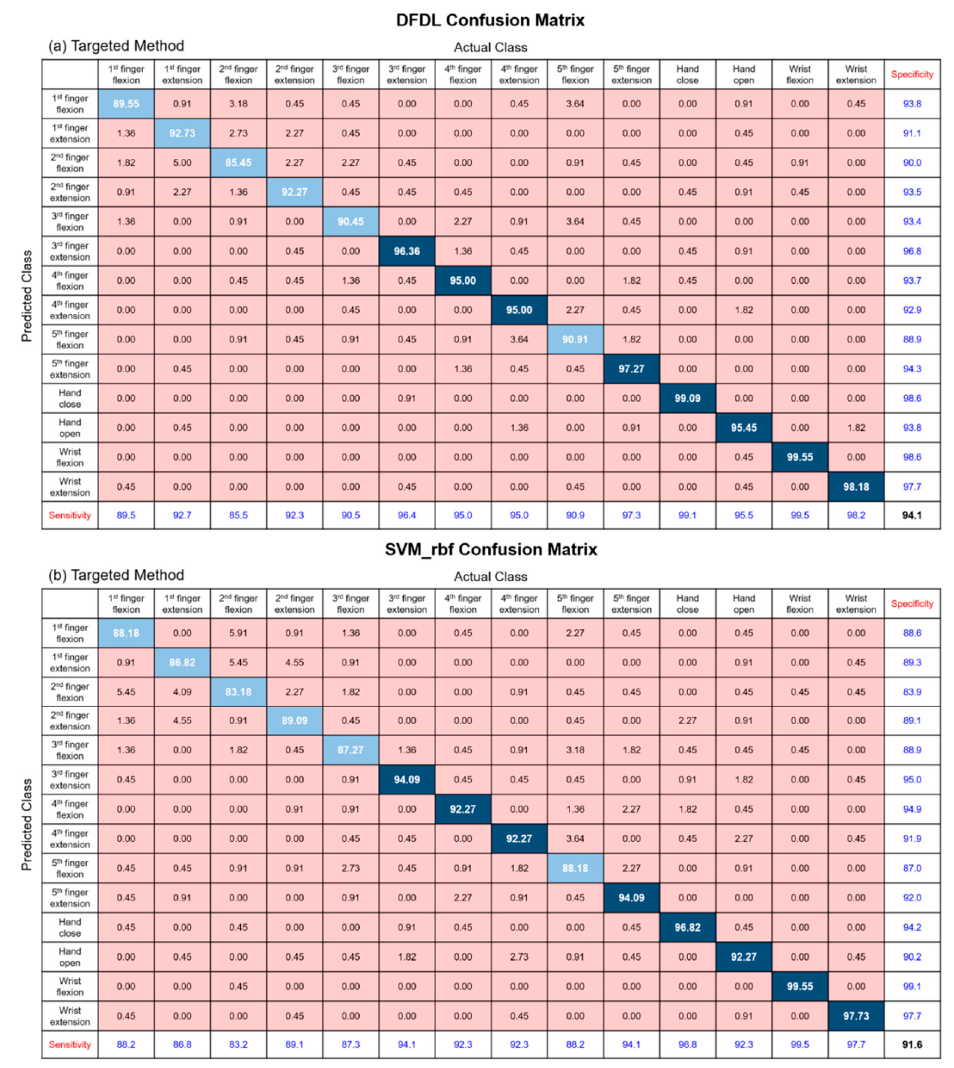
Figure 6. The classification results of each class using the targeted method represented by a confusion matrix. ( a ) DFDL with the targeted method. ( b ) SVM_rbf with the targeted method. The diagonal elements represent the classification accuracy for which the predicted class is equal to the actual class, while the off-diagonal elements indicate those that are misclassified. Sensitivities and specificities for each class are calculated.